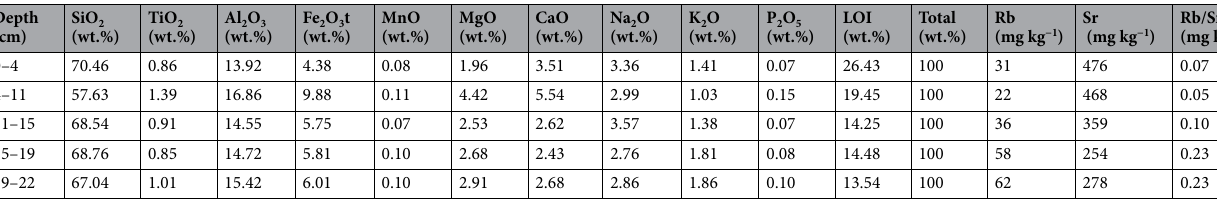
Table 1. Major element compositions and Rb and Sr contents within an Ah-horizon from the MA catchment, obtained from XRF spectroscopy. Major elements are presented LOI-free and normalized to 100 wt.%. Low silica content and simultaneously reduced Rb/Sr ratios indicate the particular dissolution of volcanic glass 20 .